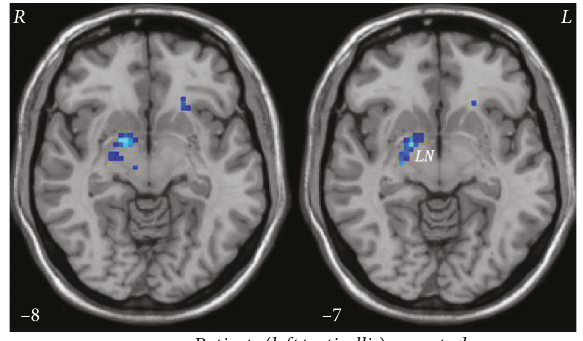
Figure 3: Signi fi cant degree centrality di ff erences in the right lentiform nucleus between patients with the left torticollis and controls. Blue denotes lower degree centrality values.